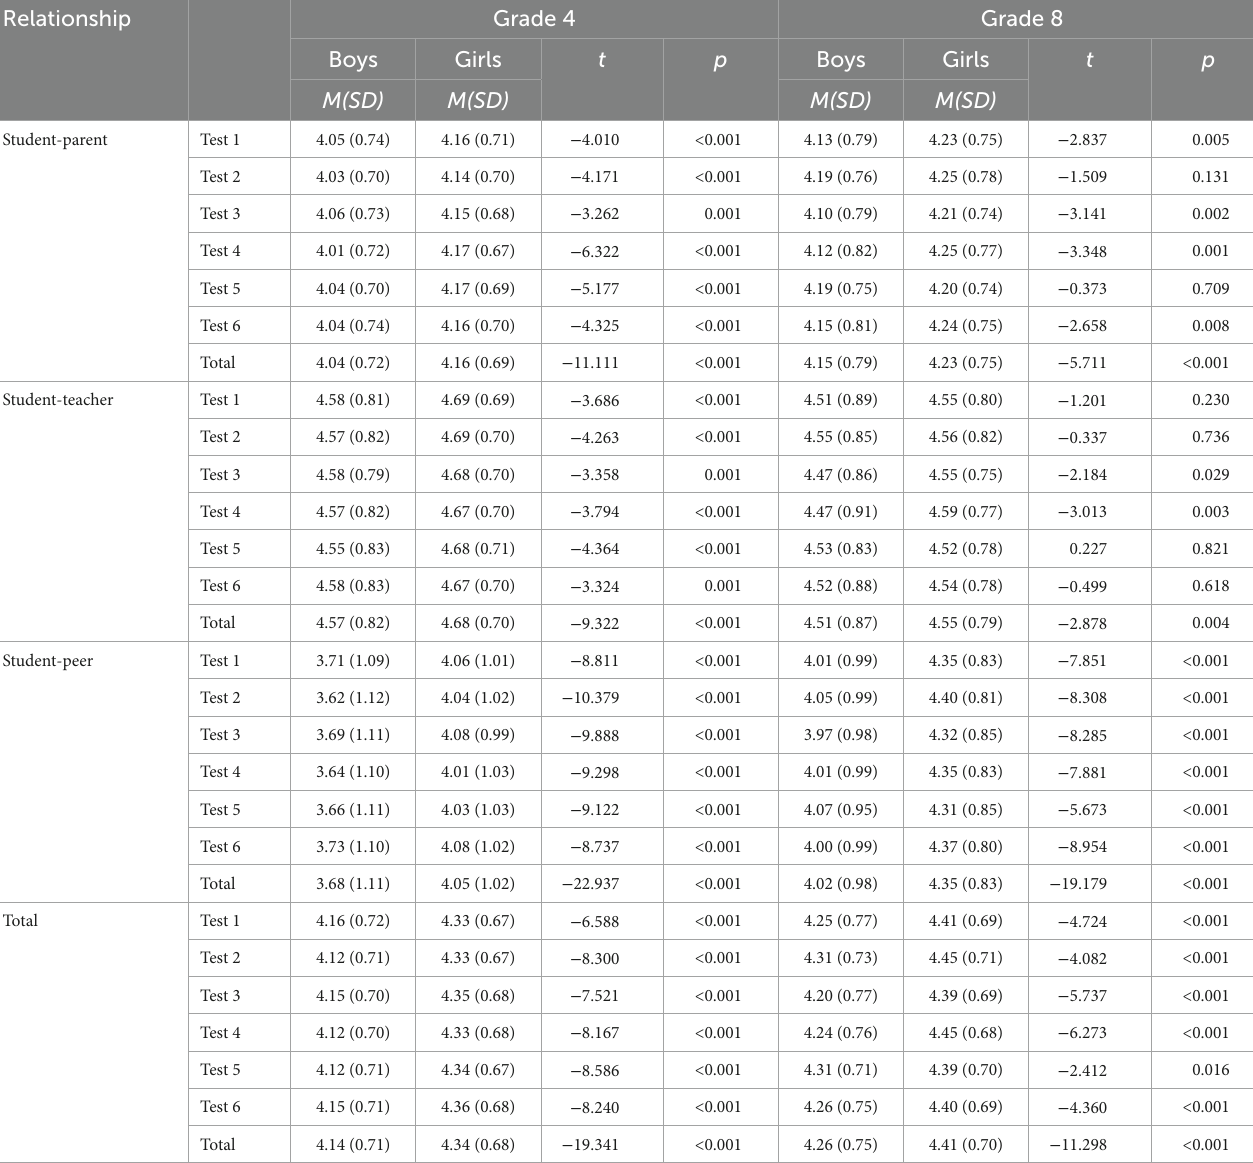
TABLE 2 Mean (SD) values and independent sample T test results for gender in personal relationships.